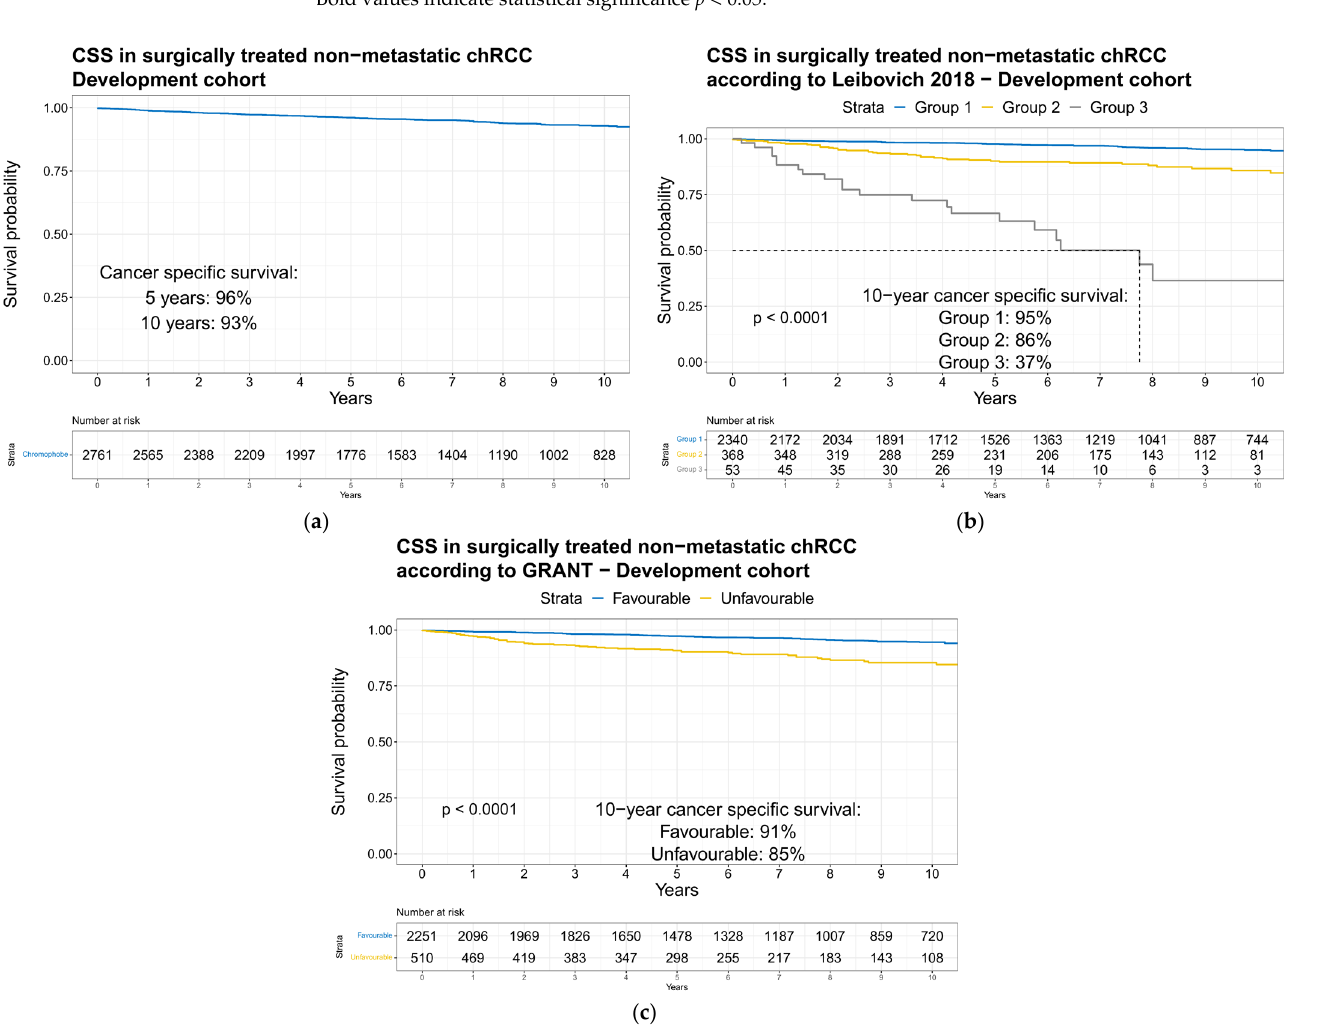
Figure 1. Development cohort: Kaplan – Meier plots with log - rank test depicting cancer - specific sur- vival over ten years in patients with unilateral surgically treated non - metastatic chromophobe renal survival over ten years in patients with unilateral surgically treated non-metastatic chromophobe carcinoma diagnosed in 2000 – 2019 Surveillance, Epidemiology, and End Results database. ( a ) Over- renal carcinoma diagnosed in 2000–2019 Surveillance, Epidemiology, and End Results all; ( b ) according to Leibovich 2018 risk categories; ( c ) according to GRANT risk categories.